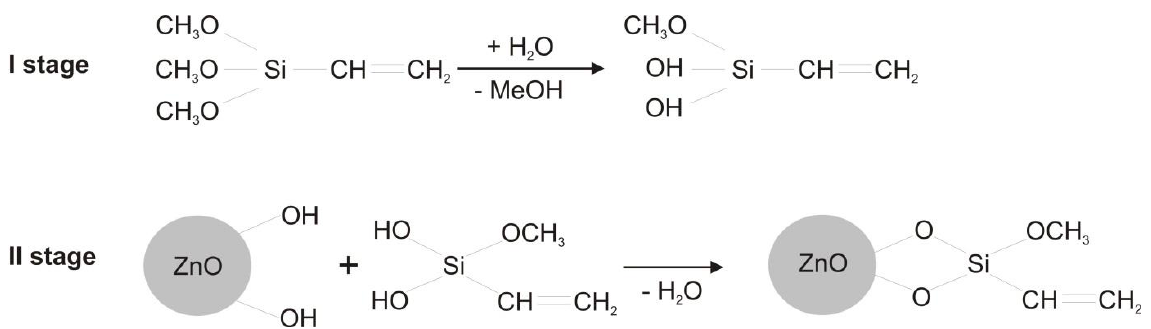
Figure 8. Probable mechanism occurring during modification of ZnO using